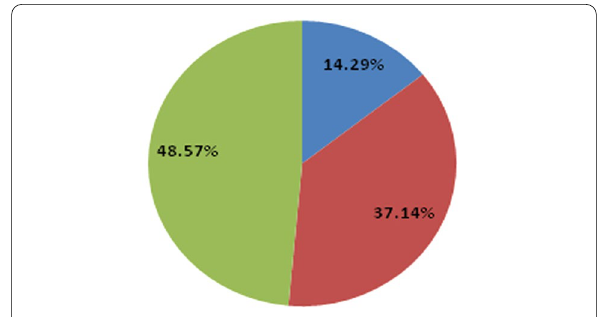
Fig. 1 The overall prevalence of the coccidian infection among the examined sheep